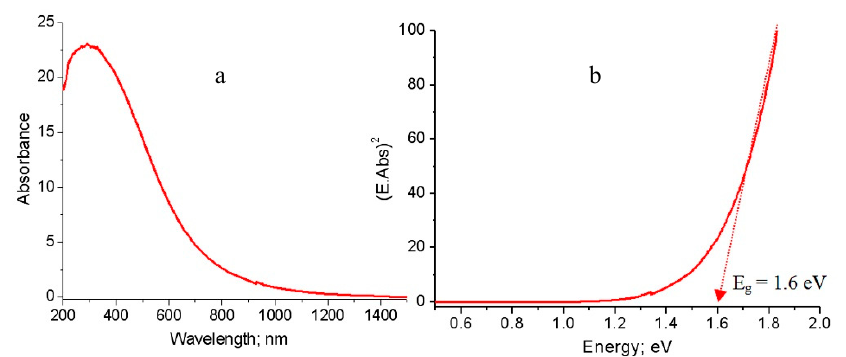
Figure 11. The prepared nanocomposite NC-3: ( a ) Absorbance spectrum and ( b ) Band gap energy.